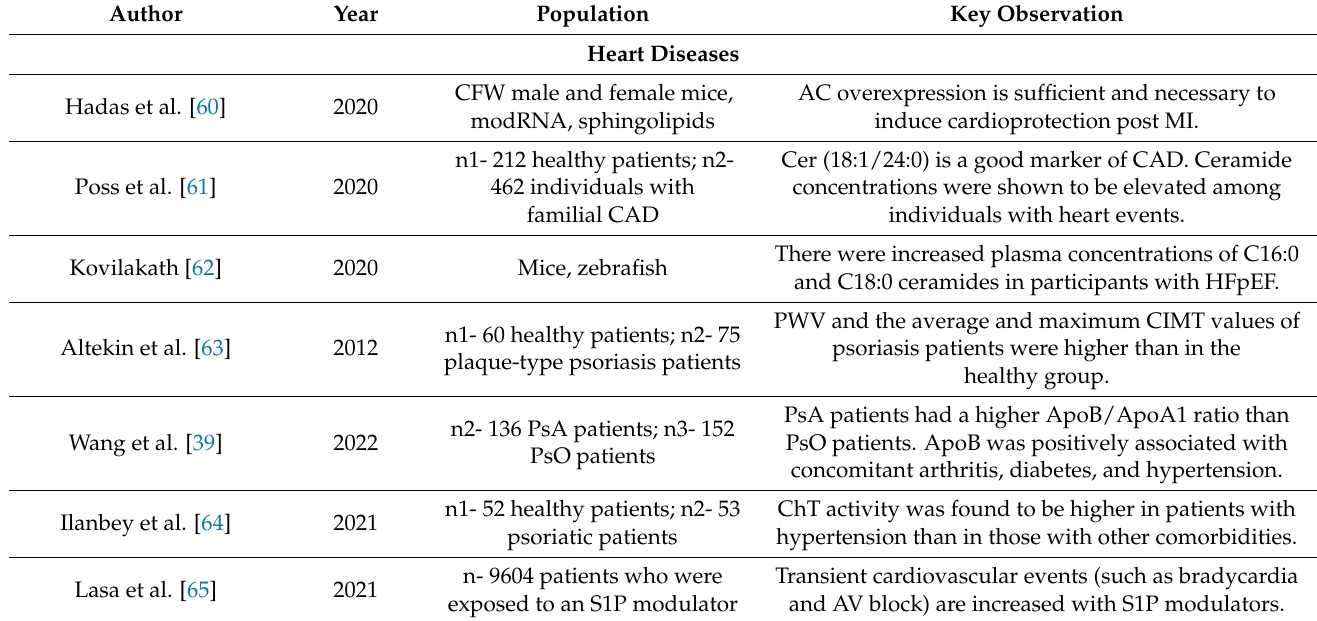
Table 7. Summary of the studies on sphingolipids in psoriasis and cardiovascular